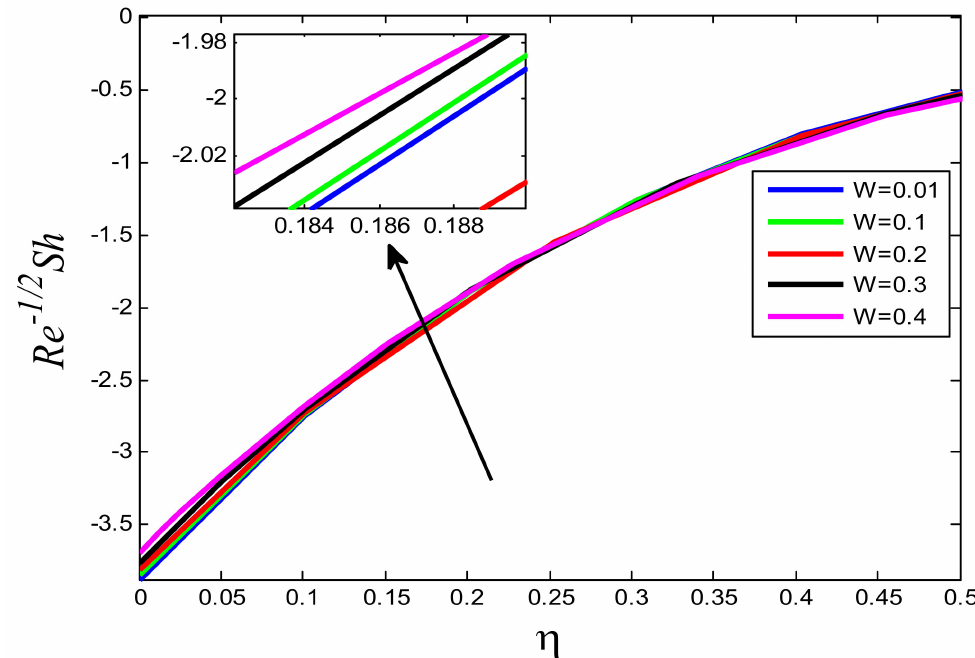
Figure 30. Influence of W on Re − 1/2 Sh .